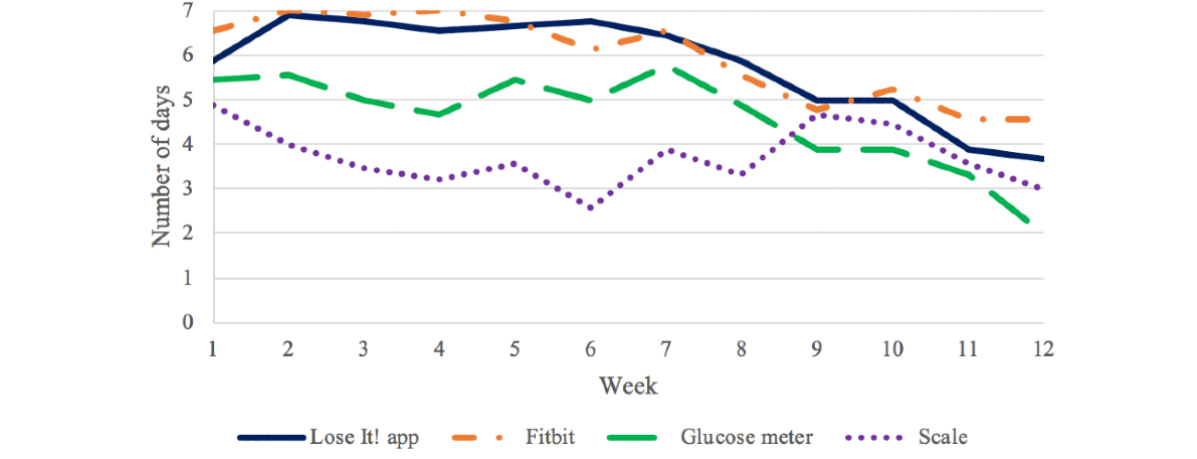
Figure 2. Number of days of using self-monitoring devices and app by